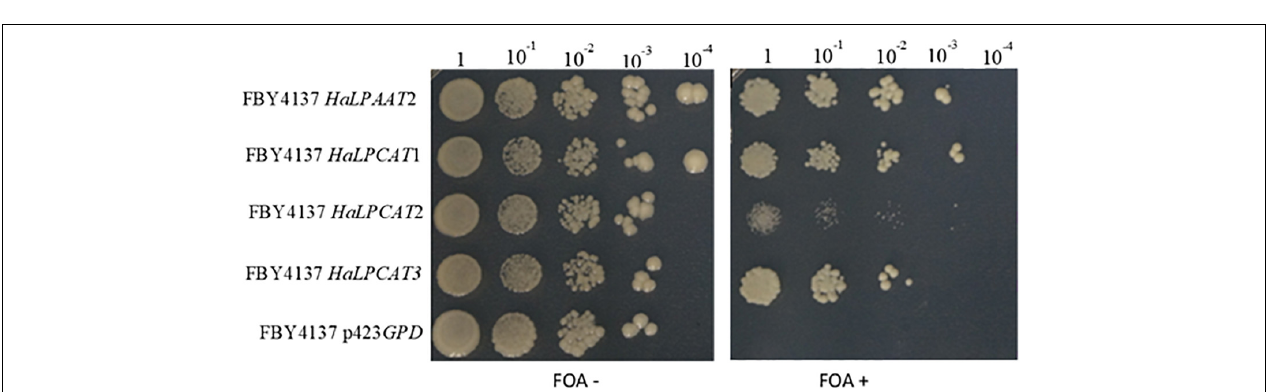
FIGURE 3 | Lyso-platelet activating factor (PAF) sensitivity test for Saccharomyces cerevisiae mutant Y02431 (ALE1 or slc4 (cid:77) ) expressing sunflower LPCATs or harboring the pYES2 empty vector (negative control) and S288C yeast strain (positive control). Yeast cells were grown overnight and induced for protein expression for 24 h were diluted 1:10 from DO 600 = 2.0 to DO 600 = 2 × 10 − 4 . The resulting 10 µ l yeast suspension was spotted on a SC-Ura agar plate containing 5 and 10 µ g/ml lysoPAF. The growth of yeast cells was evaluated after 72 h at 30 ◦ C.